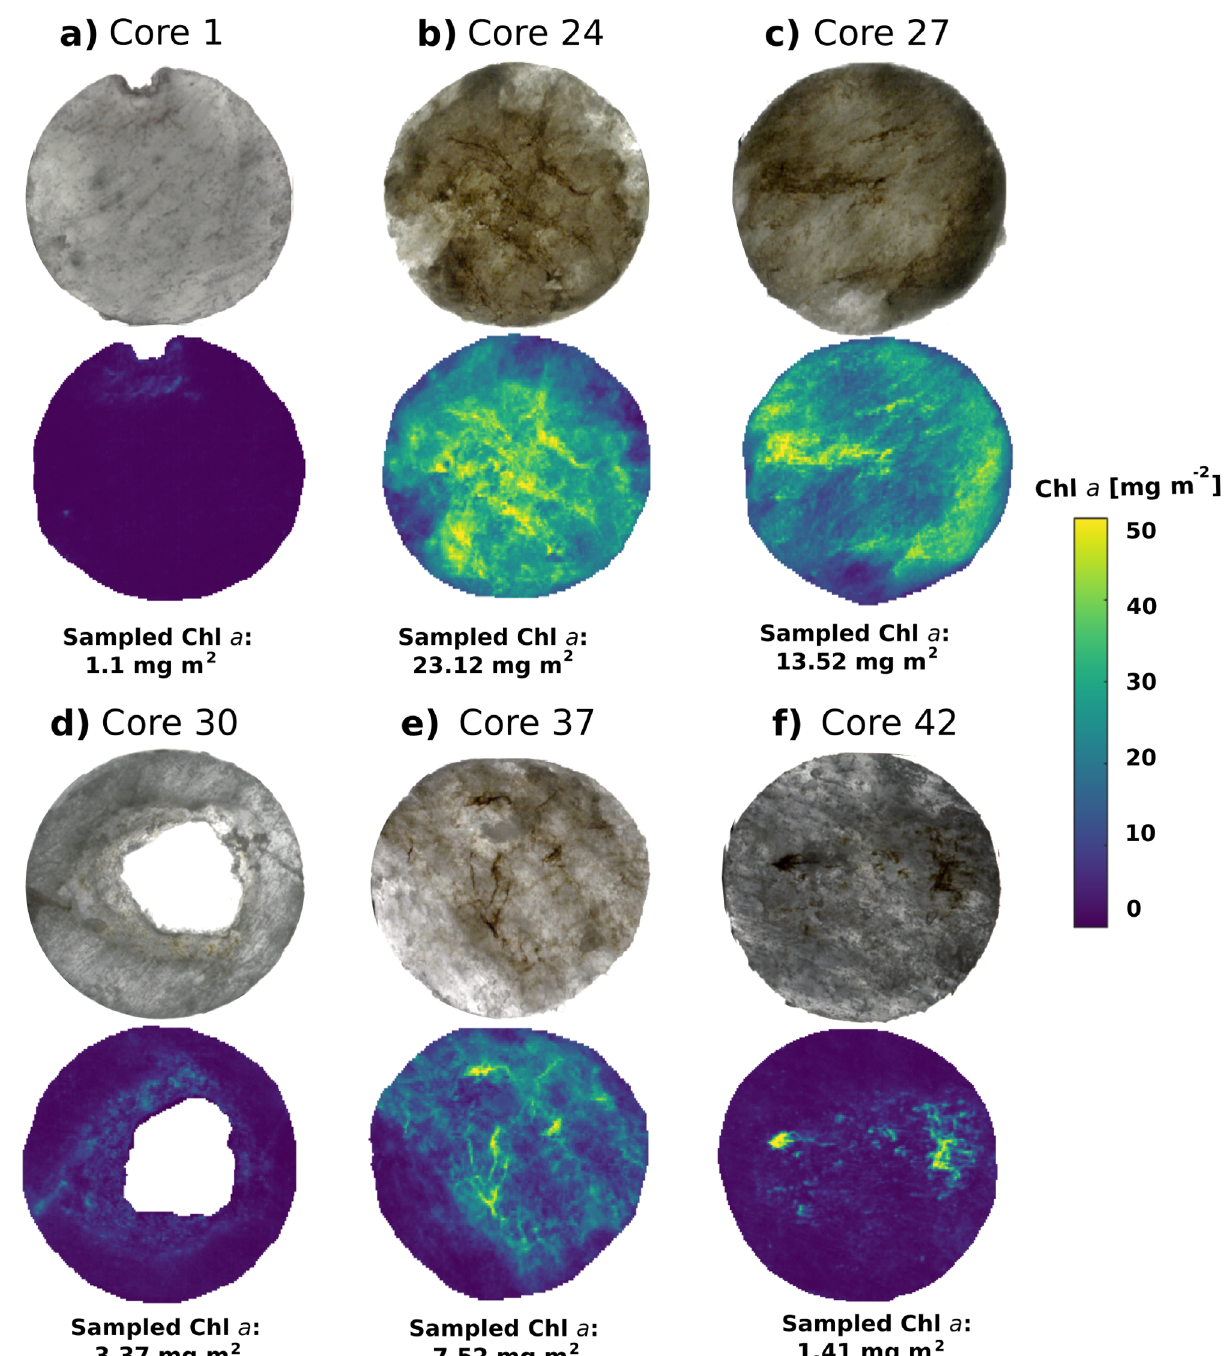
Figure 6. Application of best performing bio-optical regression model to the ex situ imagery of selected horizontal sea-ice core sections (below) along with their respective RGB composite (top). Best performing linear model was derived using the LAUC index (or log(AUC 650–700 )) (see Table 1). Fluorometrically derived concentrations of extracted Chl a value of each core section are provided to compare extracted Chl a with the optically quantified Chl a values. High variability in biomass abundance can be observed within the 0.015 m 2 (ø 14 cm) core surfaces and across different cores in a spatially explicit manner . RGB composites of the ice core sections were produced using bands at wavelengths 647 nm, 554 nm and 462 nm